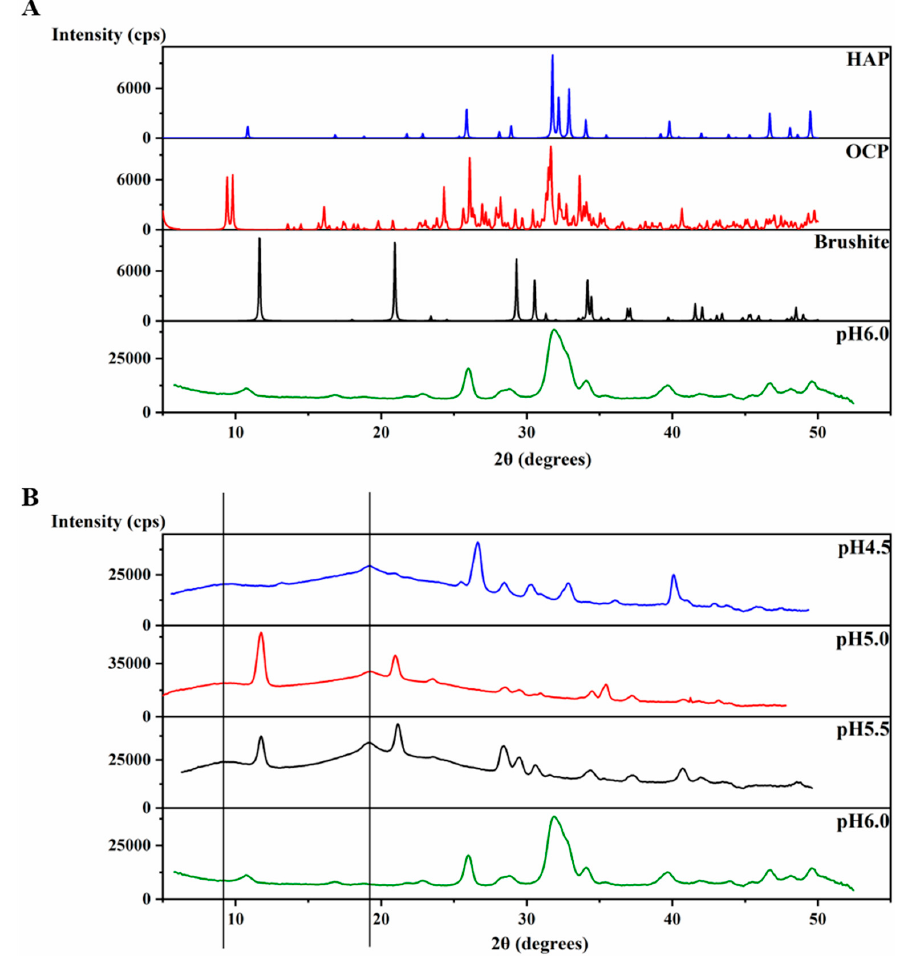
Figure 4. Characteristic XRD patterns for H175 self ‐ assembly at different pHs. ( A ) Comparison of the X ‐ ray powder diffractogram. The sample formed at pH 6.0 is the mixture of the H175 assembly and mineral precipitation. XRD of crystals of octacalcium phosphate (OCP), brushite and hydroxyapatite (HAP) were downloaded from the Inorganic Crystal Structure Database (OCD ‐ 65347 ‐ ICSD, brushite ‐ 16132 ‐ ICSD, HAP ‐ 169498 ‐ ICSD). ( B ) Comparison of the X ‐ ray powder diffractogram of the samples prepared at pH 4.5, pH 5.0, pH 5.5 and pH 6.0. (The black lines represent the d ‐ spacing of 4.8 Å and 10.1 Å for protein assemblies.).